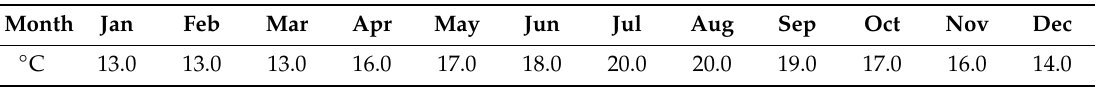
Table 7. Monthly mean temperature of the wastewater inflow of the Vienna wastewater treatment plant